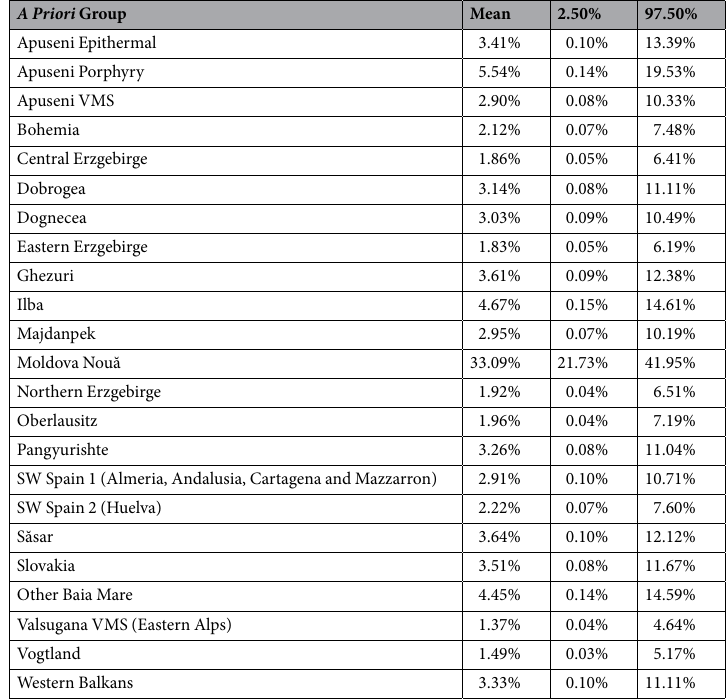
Table 5. Raw MixSIAR results for the litharge roll. Presented here are the source names, along with their modelled proportion of the Pb recorded in the artefact. Data are presented here as mean values, alongside lower and upper bounds, signifying the modelled 95% credible intervals.